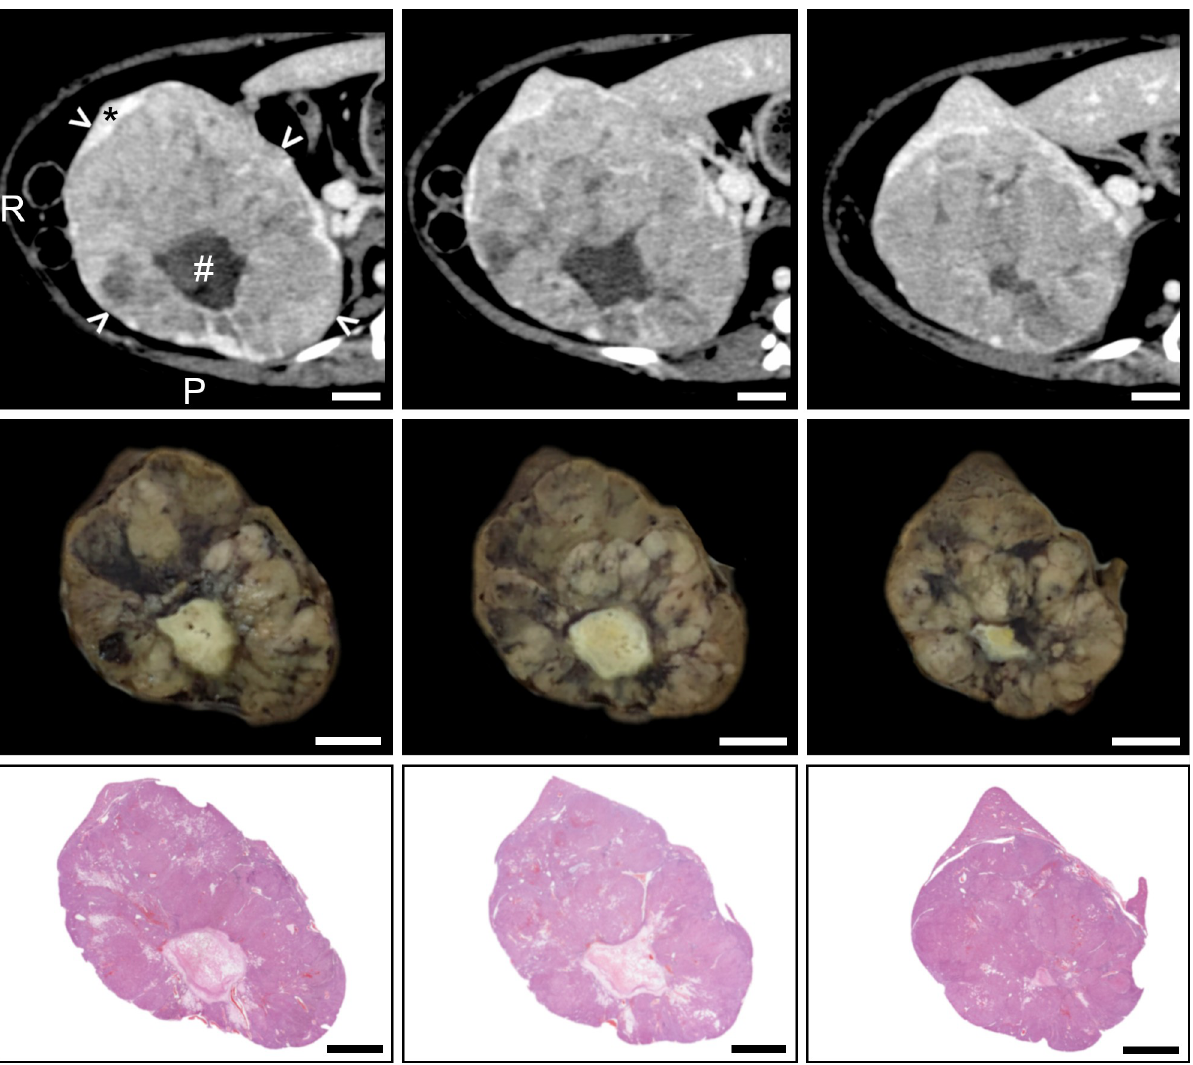
Fig 4. Sequential sections from a formalin-fixed tumor specimen with corresponding in vivo CT imaging and histopathology. Columns contain sequential axial gross pathology sections from the mold and corresponding CT and histopathology. (Top row) In vivo axial CT images acquired at the portal venous phase, showing a large tumor (arrowheads) containing central necrosis (#) with a small area of normal liver ( � ) visible at the anterior aspect. “R” and “P” represent right and posterior aspects, respectively. (Middle row) Gross pathologic specimens of the explanted tumor after sectioning using a 3D mold corresponding to the in vivo CT image slices. (Bottom row) Histopathology sections of the gross pathologic specimens. Correspondence of features can be seen between CT images of the hepatic tumor, gross pathologic specimens, and histopathologic specimens. Scale bars represent 1